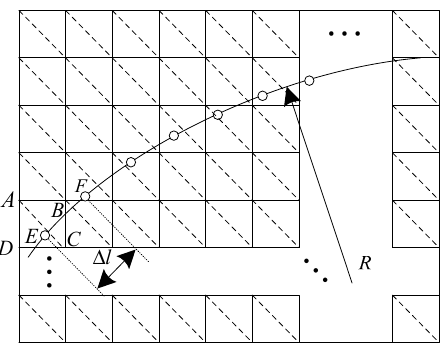
Figure 3. Sampling of elevation about steering track road roughness.